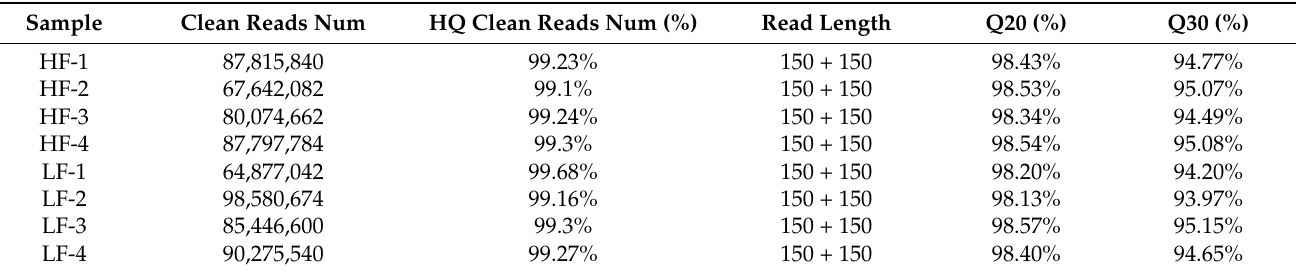
Table 3. Filtered information statistics table of reads.